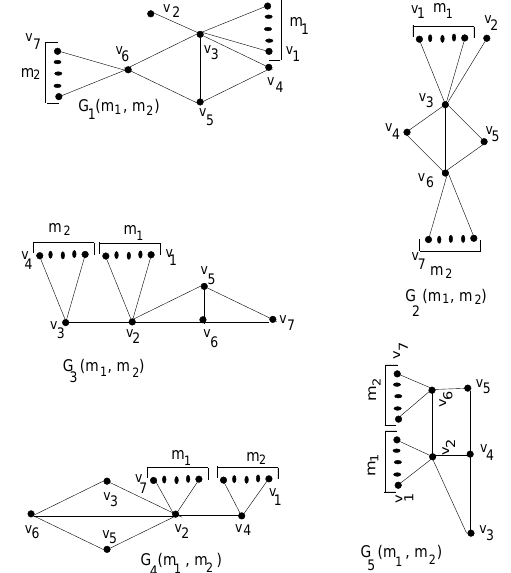
Figure 1: Bicycle graphs with three cycles G 1 ( m 1 , m 2 ) , G 2 ( m 1 , m 2 ) , G 3 ( m 1 , m 2 ) , G 4 ( m 1 , m 2 ). and G 5 ( m 1 , m 2 )